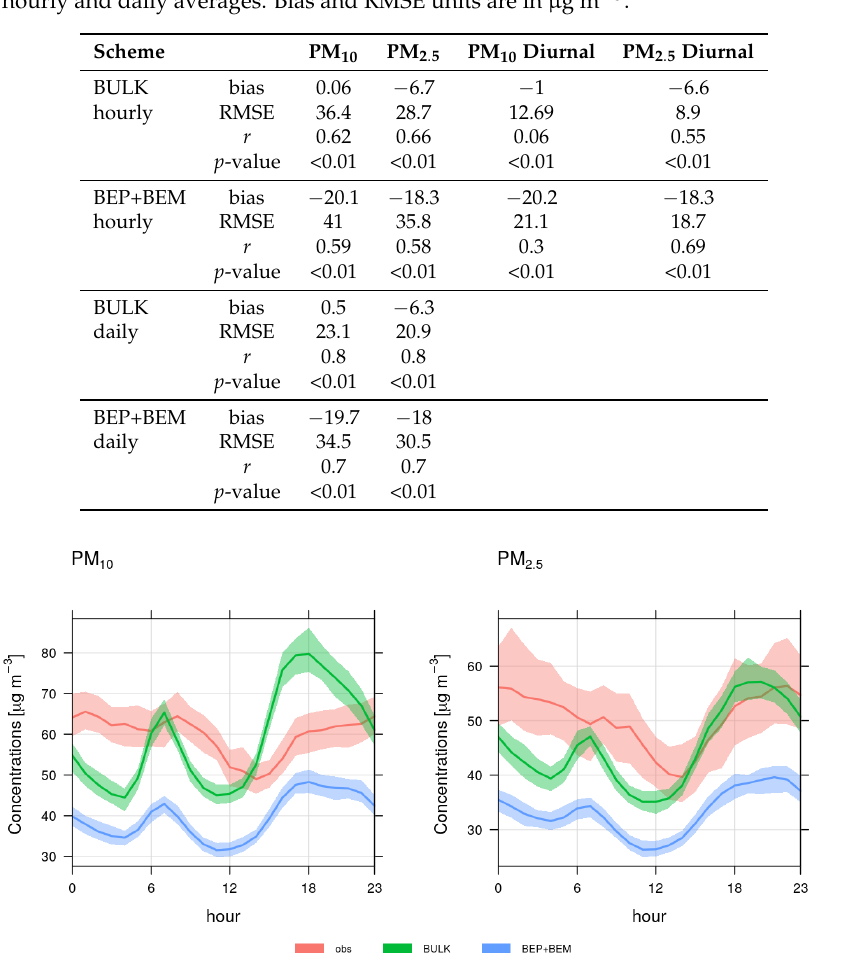
Table 3. Statistical results (bias, RMSE, r , correlation p -value) of observations and simulations: air quality; hourly and daily averages. Bias and RMSE units are in µ g m − 3 .